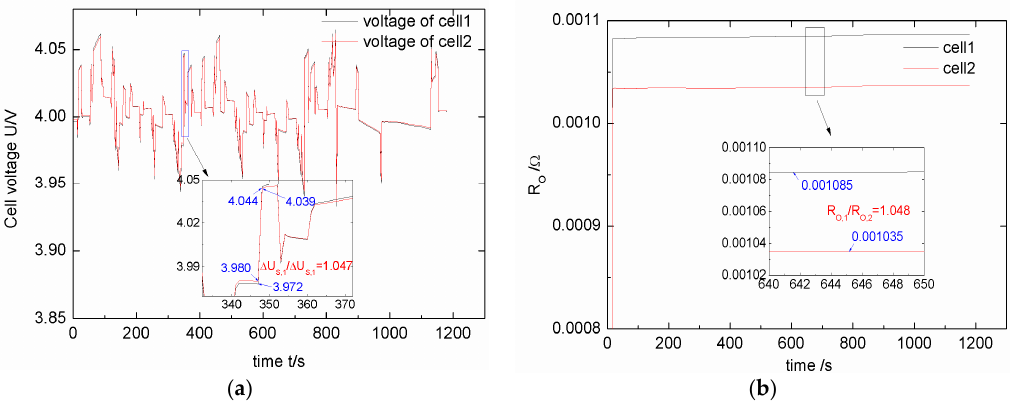
Figure 4. Voltage and ohmic resistance of the two cells: ( a ) voltage of the two cells; and ( b ) ohmic resistance of the two cells.